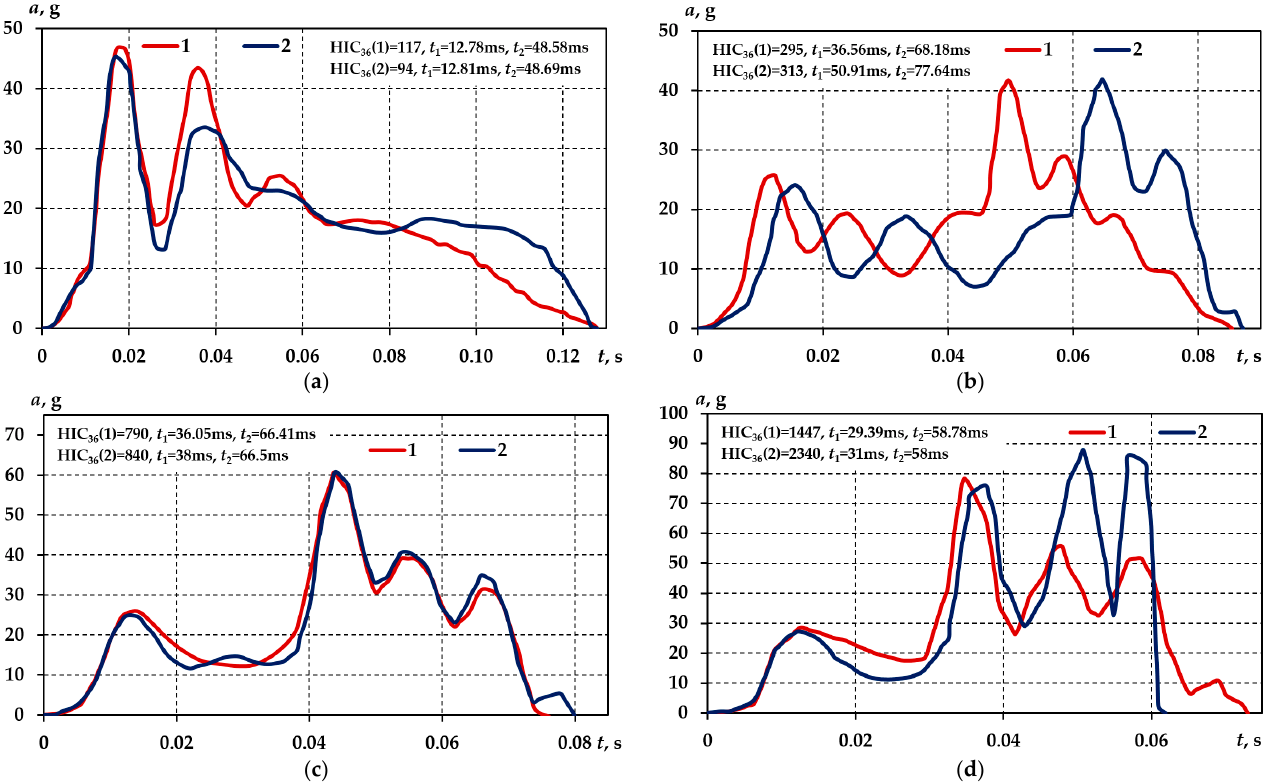
Figure 24. Accelerations of the 3rd zone at different collision velocities: 40 km/h ( a ), 50 km/h ( b ), 64 km/h ( c ), 75 km/h ( d ); (1—2nd zone of original characteristics; 2—damaged 2nd zone).